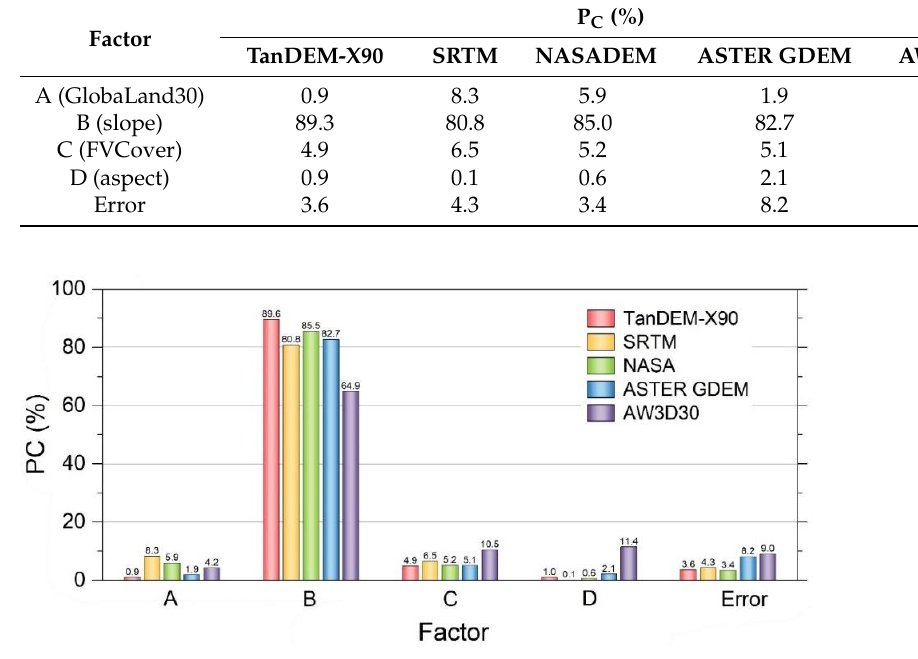
Figure 16. Percentage of contribution of each factor to MAE in the study area.